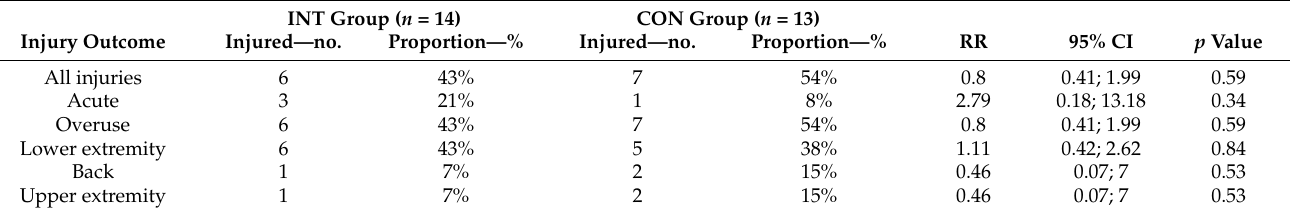
Table 2. Injury incidence.